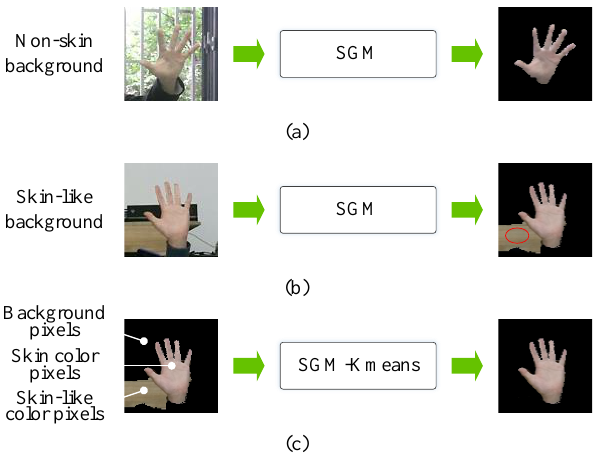
Figure 2. ( a ) Gesture segmentation in non-skin background by SGM method. ( b ) Gesture segmenta- tion in skin-like background by SGM method. ( c ) Gesture segmentation in skin-like background by SGM-Kmeans